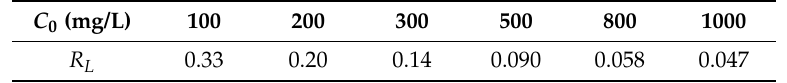
Table 4. R L data for Pb(II) adsorption on the MIL-125-CS beads based on the Langmuir